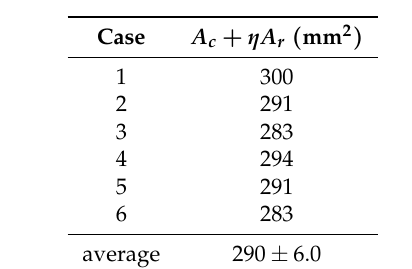
Figure 10. Experimental result, ø16 mm. Table 2. Cross-sectional area, ø16 mm.